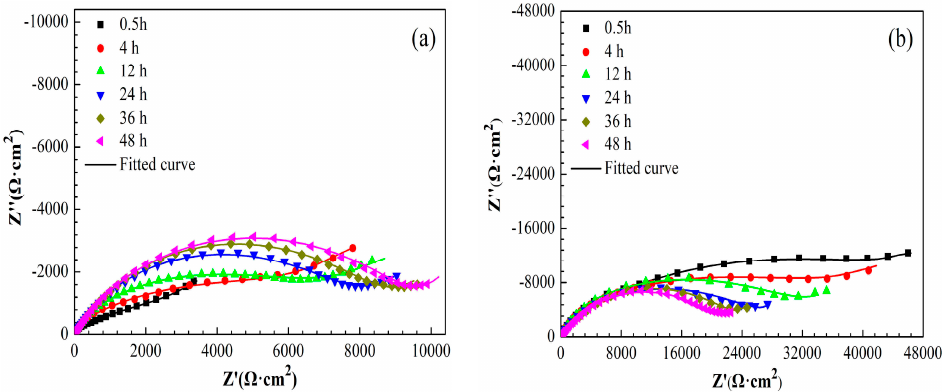
Table 4. Polarization parameters of copper electrode, copper electrode with 1-dodecanethiol SAM and